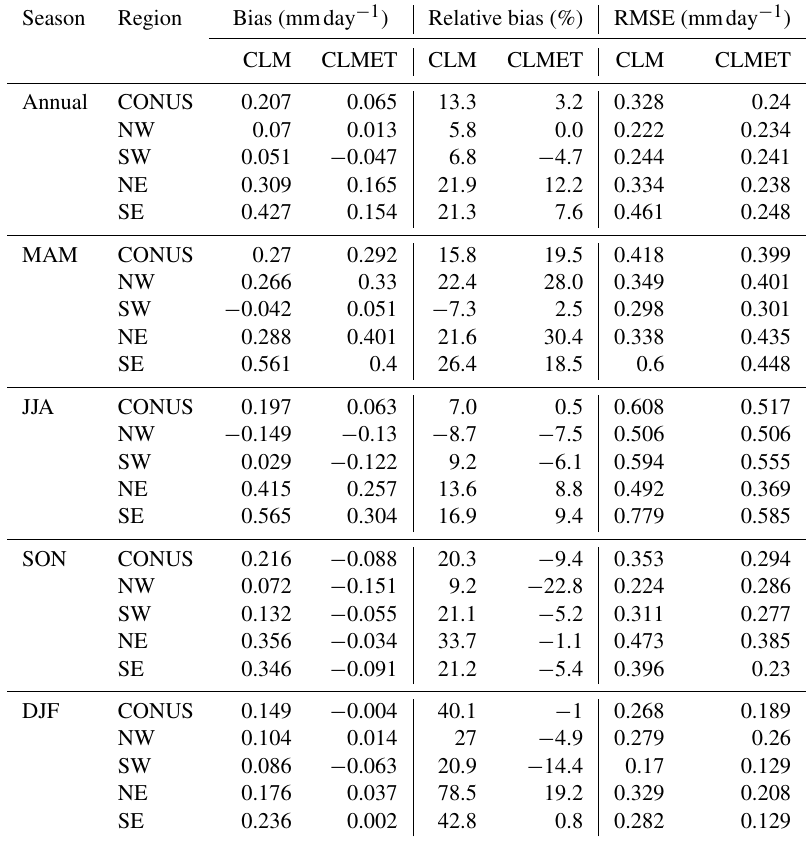
Table 3. Similar to Table 1, but based on comparison with FLUXNET-MTE ET during the period 2000–2011.